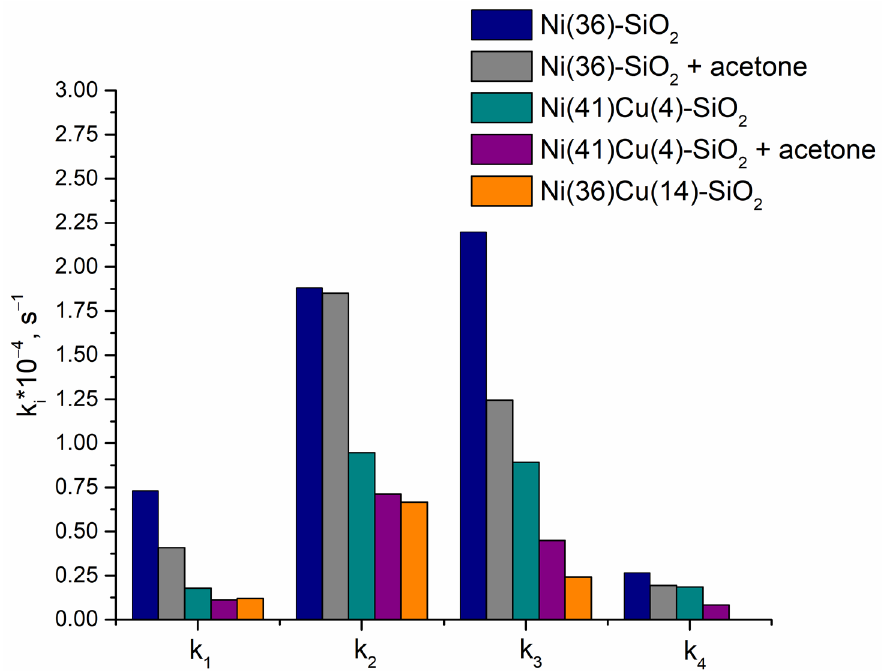
Figure 7. Comparison of the rate constants calculated for the TH process over Ni(36)–SiO 2 , Ni(41)Cu(4)–SiO 2 , and Ni(36)Cu(14)–SiO 2 at 250 °C.